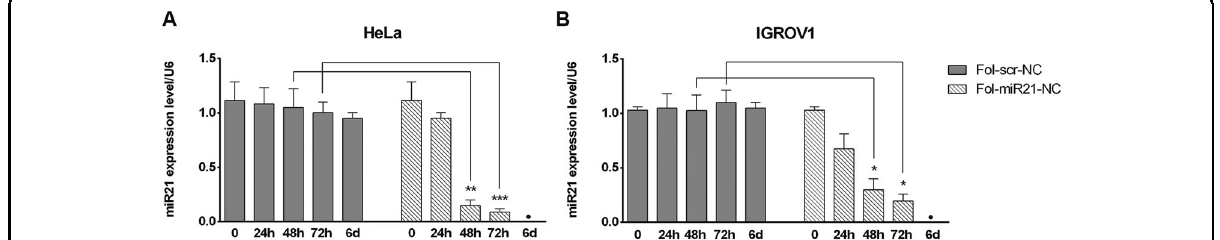
Fig. 3 MiR-21-silencing activity in HeLa and IGROV1 cells of Fol-miR21-NCs compared to Fol-scr-NCs. qPCR analysis of miR-21 expression level is reported for HeLa ( A ) and IGROV1 ( B ) cells incubated with Fol-NCs for different time intervals. Values are expressed as mean ± S.E.M. of three